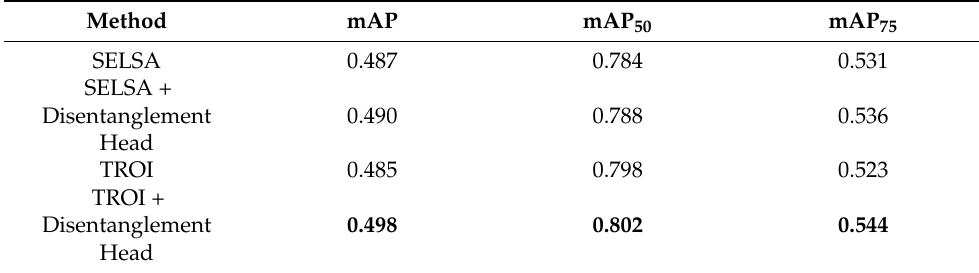
Table 4. Comparison of the proposed framework against the baseline using